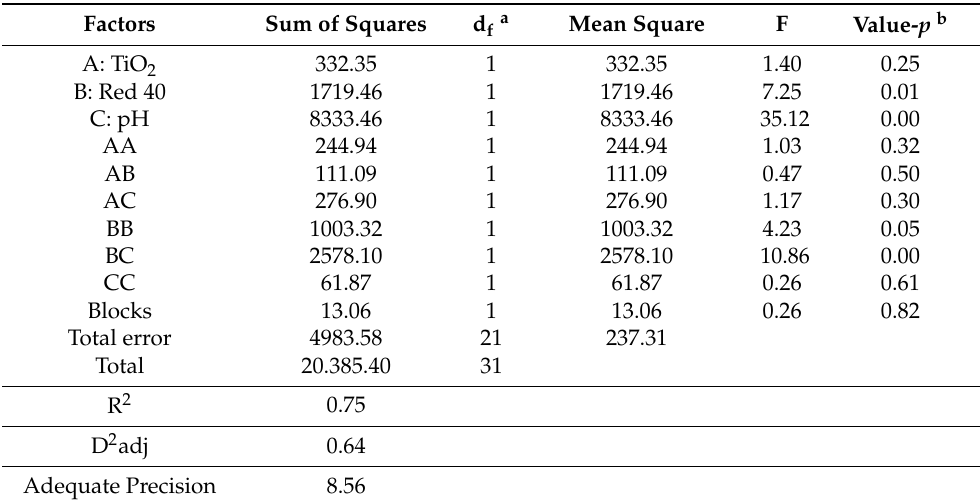
Table 4. ANOVA results for the optimization of the removal efficiency of FD&C Red 40 dye with CS-TiO 2 -GLA